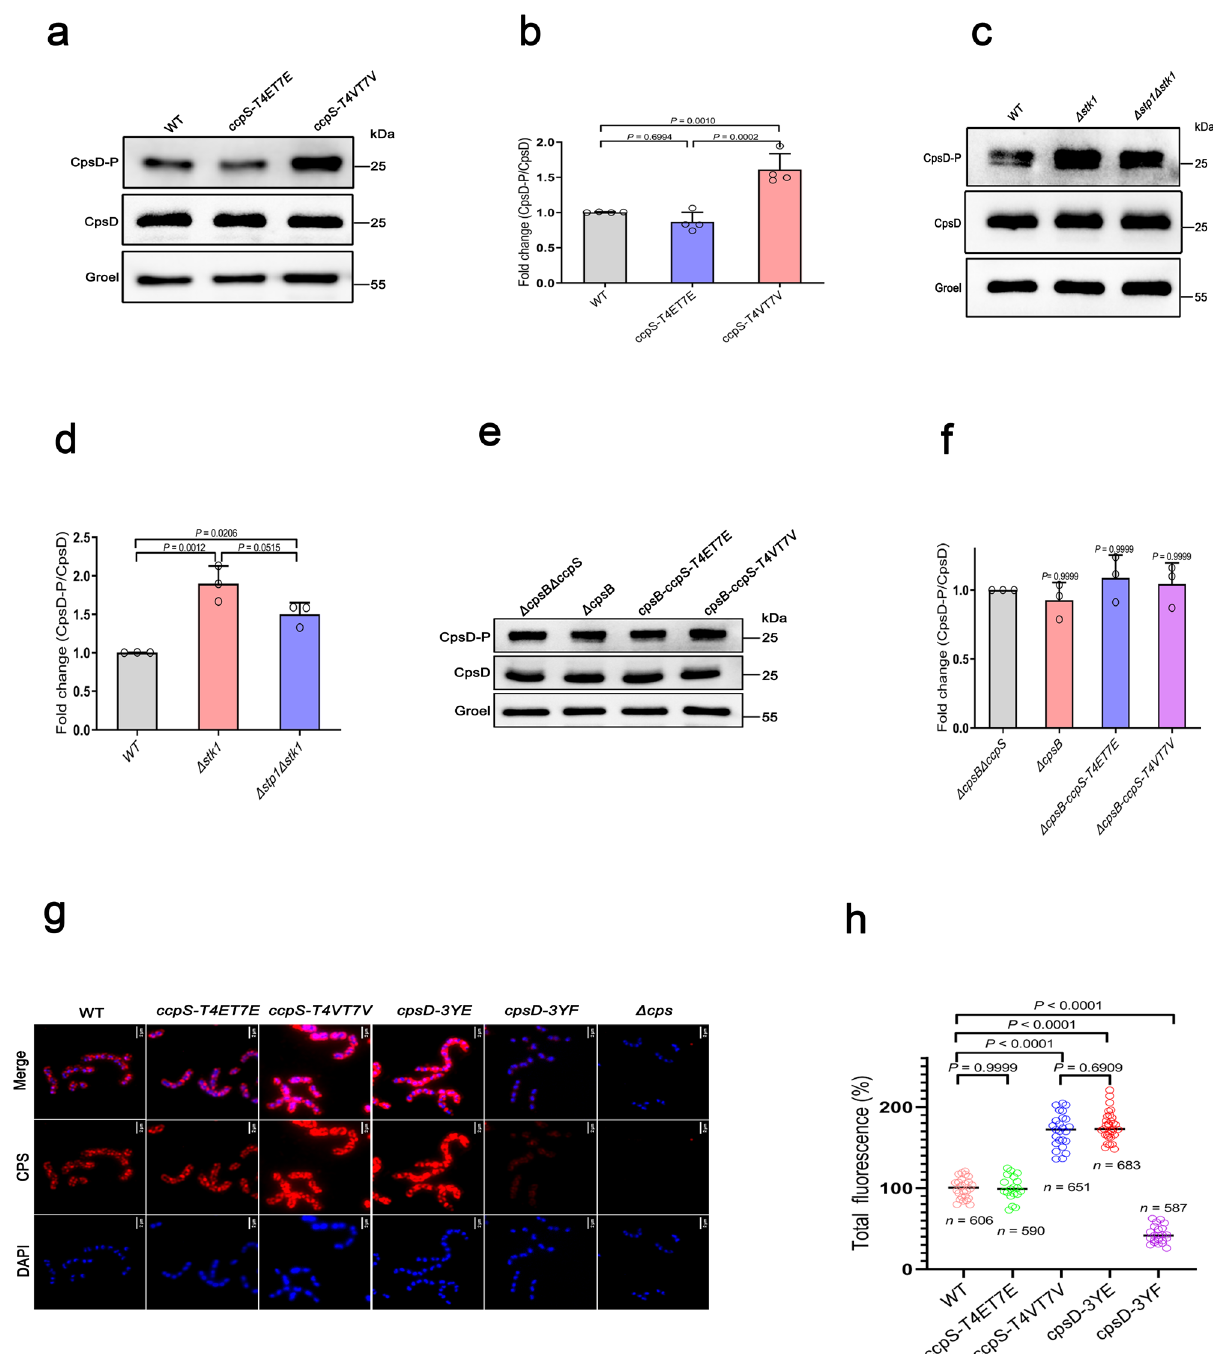
Fig. 6 | CcpS regulates CpsD phosphorylation and then in fl uences CPS synth- esis in S. suis . a , c , e Anti-phosphotyrosine immunoblot analysis of whole-cell lysates from the indicated strains. Immunoblot shows phosphorylated CpsD and total CpsD protein levels using anti-phosphotyrosine and anti-CpsD antibodies, respectively. Groel: loading control. b , d , f Bar graphs showed the percentage of phosphorylated and total CpsD in different groups (density analysis for a , c , e , respectively). The values were normalized to the WT levels, considered 1. Data represent mean±SD from n =4 ( b ) and n =3 ( d , f ) biologically independent experiments. g Detection of CPS in WT and mutant strains. CPS were immunode- tected with a mouse anti-serotype 2 CPS polyclonal antibody. CPS fl uorescent signal (red, middle row), DAPI (blue, bottom row), and overlays between DAPI and